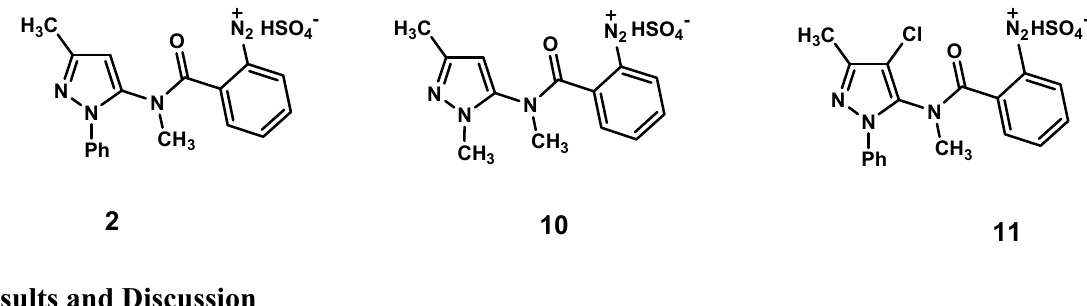
Figure 1. Diazonium hydrogen sulfates 2 , 10 and 11